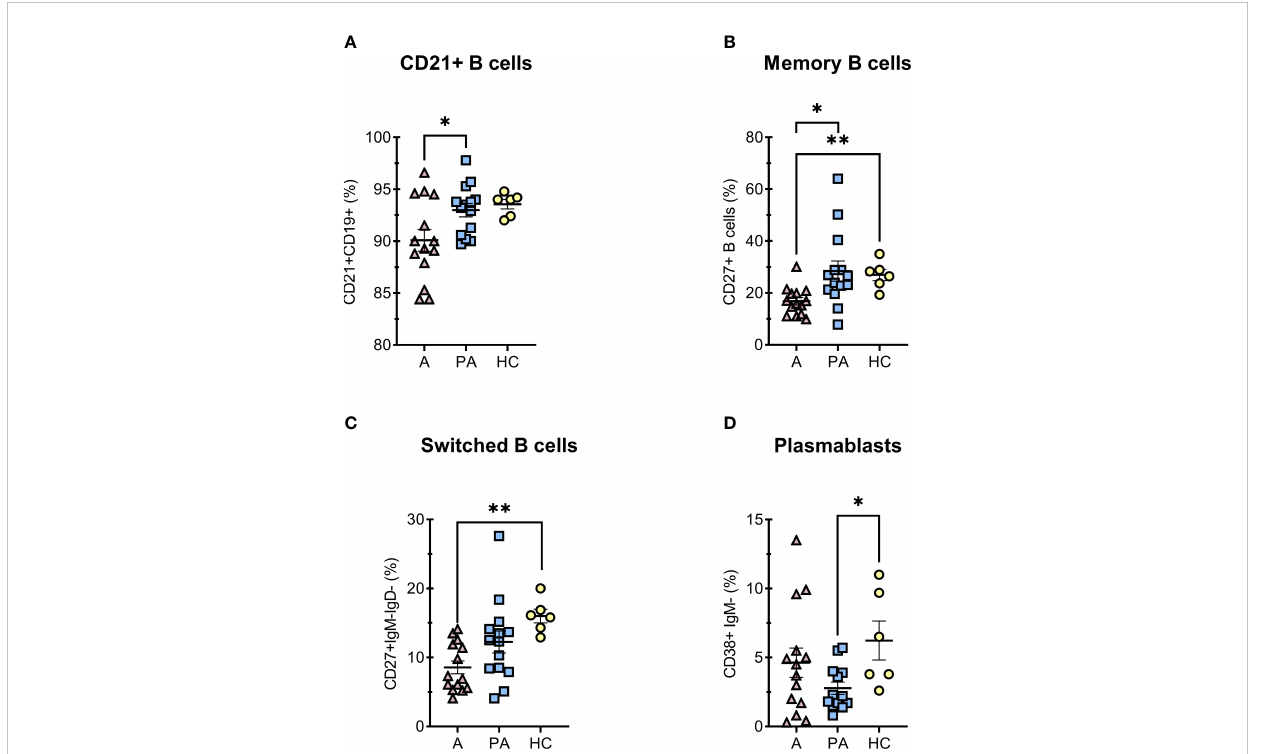
FIGURE 3 Percentage of B cell subpopulations in peripheral blood of MIS-C patients in acute (A) and convalescent (PA) phase compared with age-matched healthy controls (HC). A – F, percentages of (% of all CD19+) (A) immunocompetent mature B cells CD21+, (B) memory CD27+IgM- B cells, (C) memory-switched CD27+IgM-IgD- B cells and (D) plasmacytoid CD38+IgM- B cells. Pink and blue shading represents patients with MIS-C in acute (A, n = 14) and convalescent (PA, n = 14) phase of the illness. Yellow shading represents healthy controls (HC, n = 6). The Shapiro-Wilk normality